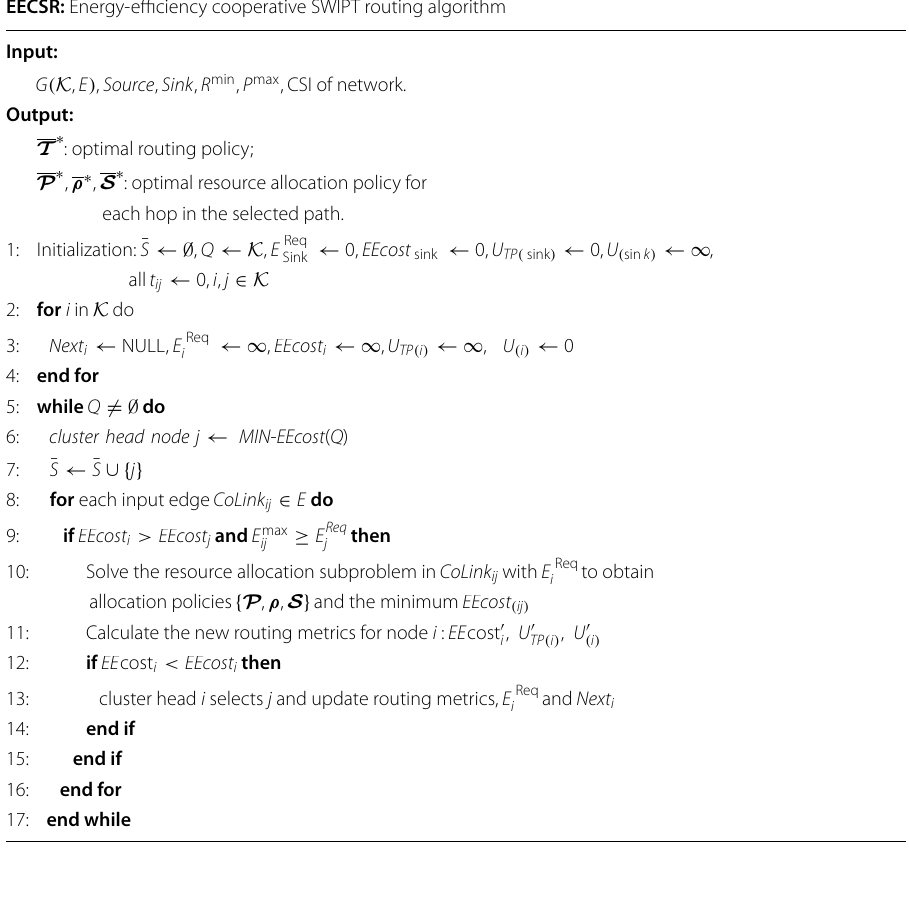
Table 1 Energy‑efficiency cooperative SWIPT routing algorithm EECSR: Energy‑efficiency cooperative SWIPT routing